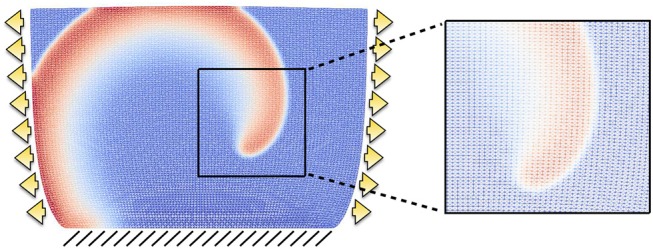
Example of structured mesh employed in the computational results. The grid is displayed on the deformed configuration when the domain is subject to traction (arrows) and fixed displacement (lines) boundary conditions, and a zoom exemplifies the mesh resolution for a rather coarse spiral front.